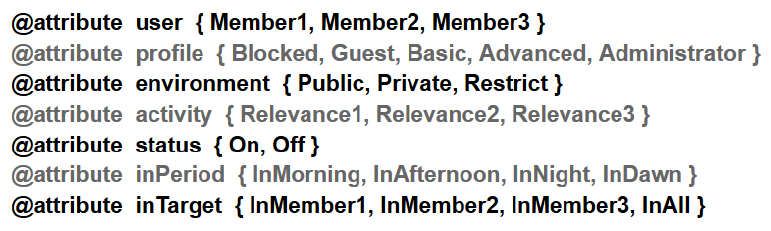
Figure 4. Predictor attributes.